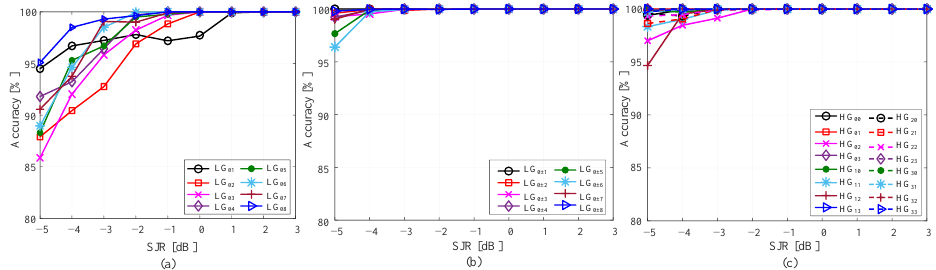
Figure 6. Individual mode accuracy for ( a ) 8-ary LG, ( b ) 8-ary Mux-LG, and ( c ) 16-ary HG modulation schemes.